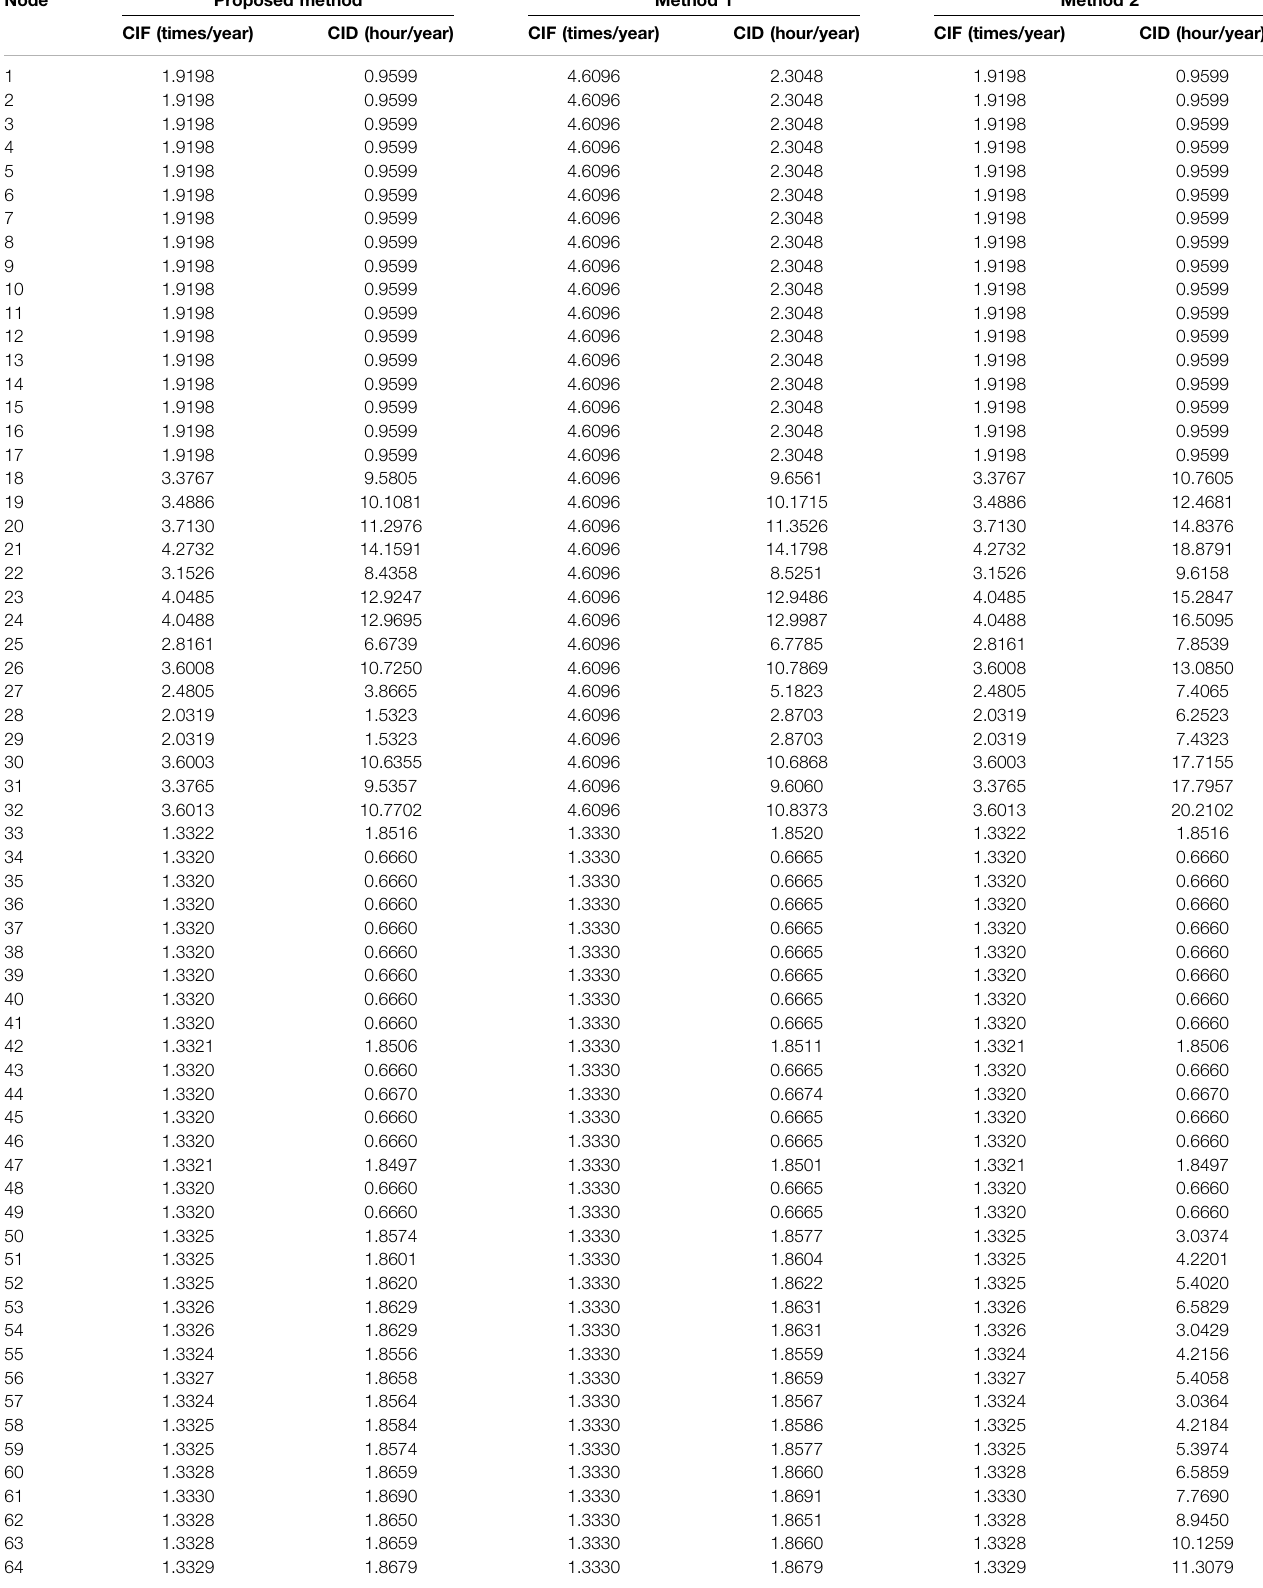
TABLE 5 | Nodal CIF and CID of the three